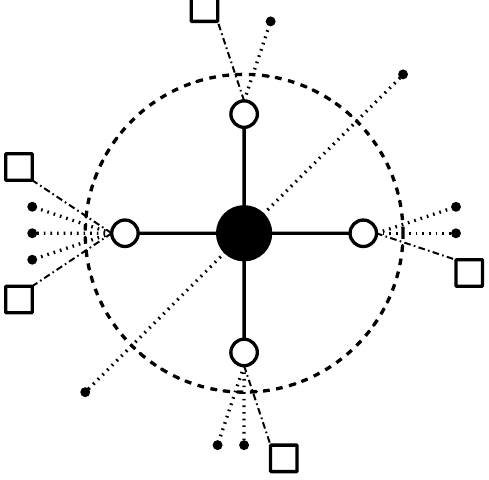
Figure 2. Schematic of location assignment. Shown is a piece of network A that is centered around a node that is chosen at random for location assignment during this time step (shown as the black filled node at the center). The empty circles represent unassigned neighbors of the central node, and the nodes inside the big dashed circle are the ones to be assigned during this time step. The empty squares represent unassigned second neighbors of the central node. Finally, the small filled circles represent assigned nodes. Location assignments in the random walk process will be correlated only for the nodes that are connected with solid